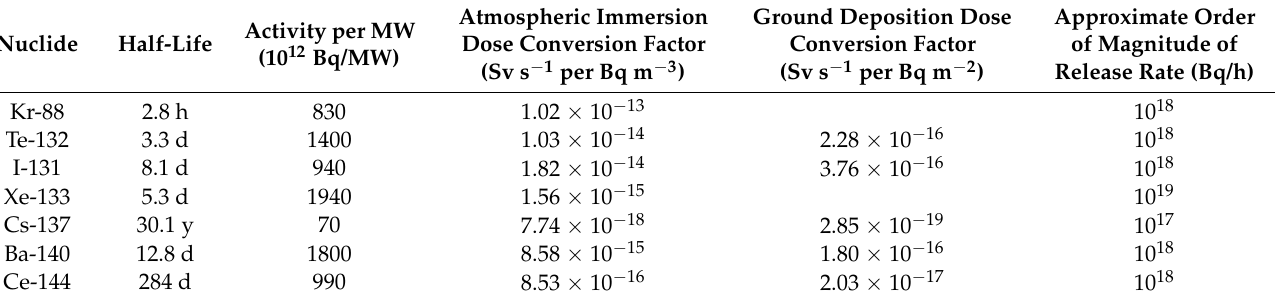
Table 1. Information on the seven radionuclides set as source item.